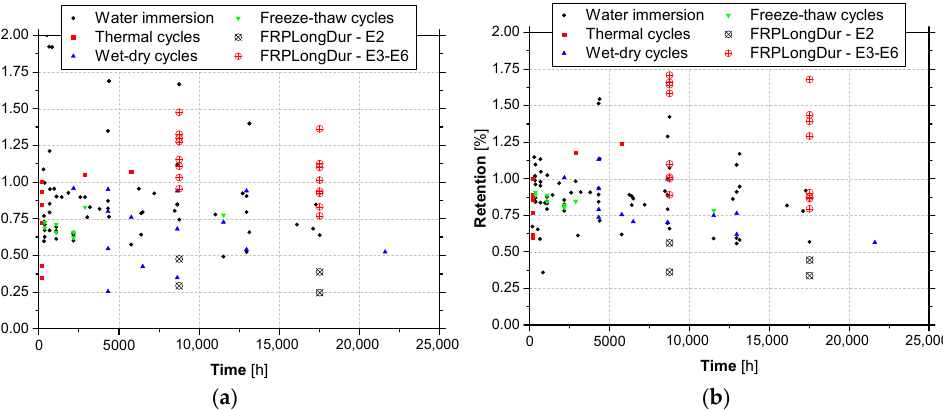
Figure 14. Retention values of ( a ) elastic modulus and ( b ) tensile strength of epoxy adhesives under accelerated ageing tests protocols versus natural ageing (E3 to E6).